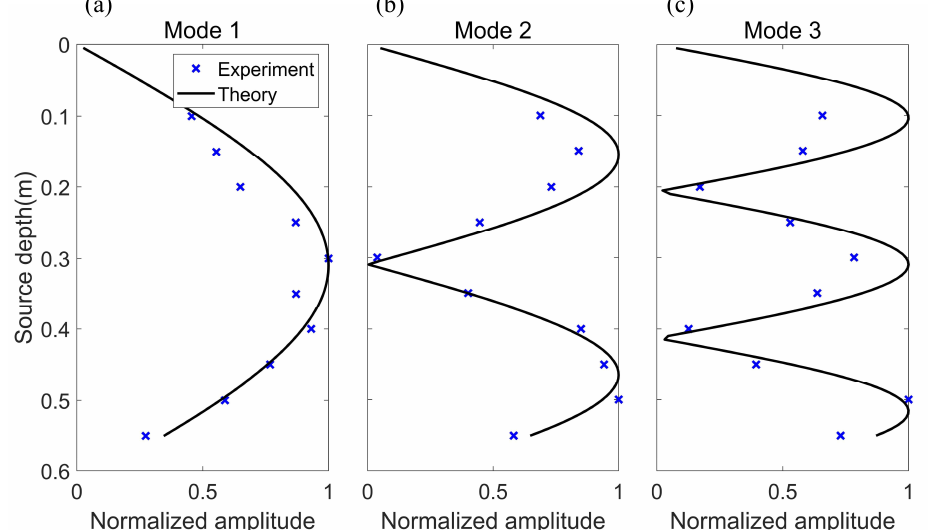
Figure 11. Mode amplitude versus source depth for the Scholte wave and normal modes (thickness of sediment is 12mm, source frequency f = 50 kHz). The blue cross is the experimental result, and the black line is the theoretical result (mode shape function). ( a ) Mode 1. ( b ) Mode 2. ( c ) Mode